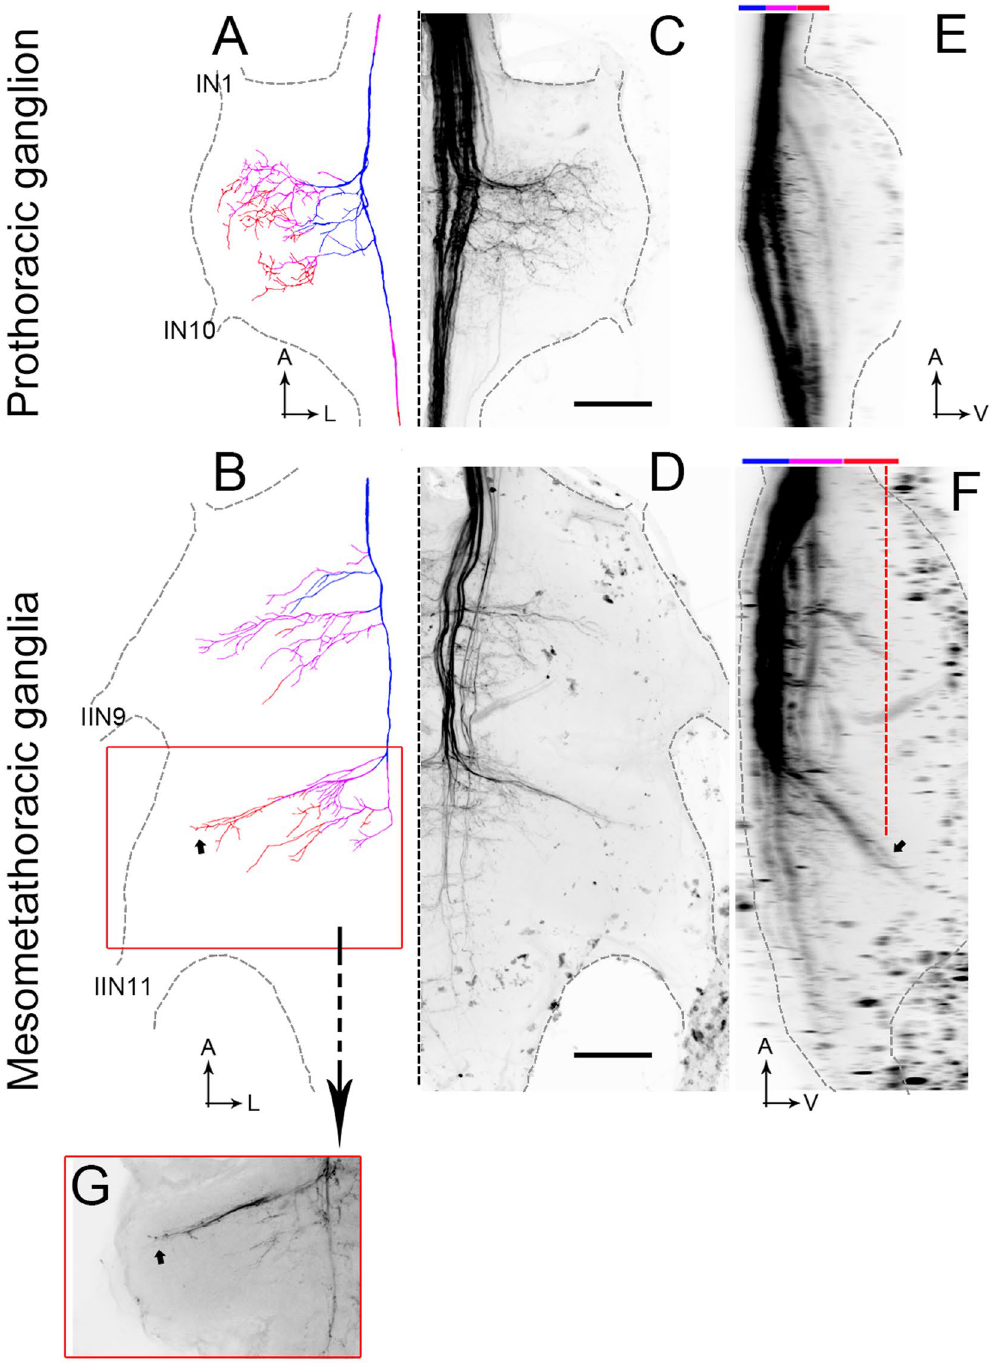
Figure 3. Thoracic anatomy. ( A , B ) Drawing of DNIII 4 in the thoracic ganglia. Blue shows dorsal axon collaterals and orange shows ventral collaterals. ( C , D ) Mass-fills showing the DNIIIs and other descending neurons in the thoracic ganglia (reflection of drawings in ( A and B ). ( E , F ) Side views of the mass fills shown in ( C ) and ( D ). The upper color bars show the depths as represented in A and B. The small arrow in F shows the locations of the terminals indicated by the same small arrow in B. The dashed orange line in F shows the depth plane of the photograph taken in ( G ). ( G ) Photograph of the terminals highlighted by the small arrows in B and F. The orange box surrounding ( G ) is shown as an orange box in B. Scale bars = 100 µ m. A = anterior, L = lateral. IN1 and IN10 are prominent nerves in the prothoracic ganglion. IIN9 and IIN11 are the largest nerves exiting the mesometathoracic